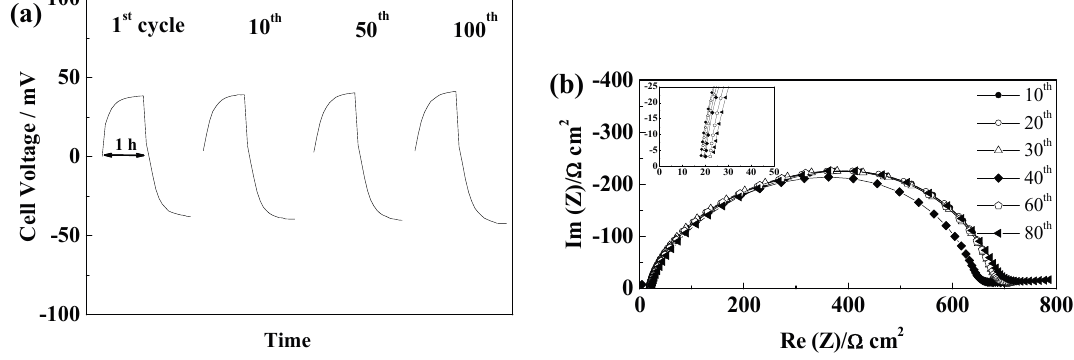
Figure 5. Evolution during cycling at 40 °C and 0.1 mA·cm − 2 of a PYR incorporating a GF/C separator ( a ) Voltage profile of a GF/C cell; ( b ) Evolution of the impedance spectra at 21 °C of the GF/C cell shown in ( a ).